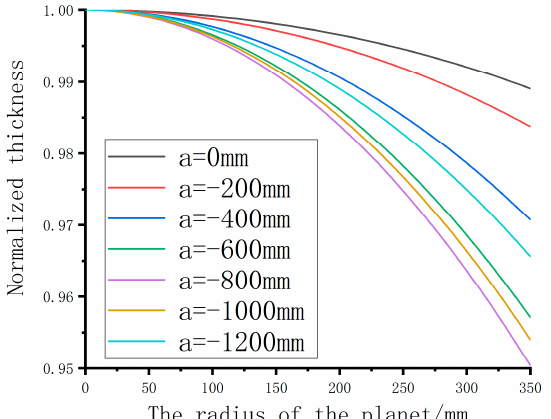
Figure 7. Theoretical film thickness distribution as a function of the radius of the planet at different values of the offset of the source position from the center of the vacuum chamber ( H = 1500 mm, R = 620 mm, n = 2).